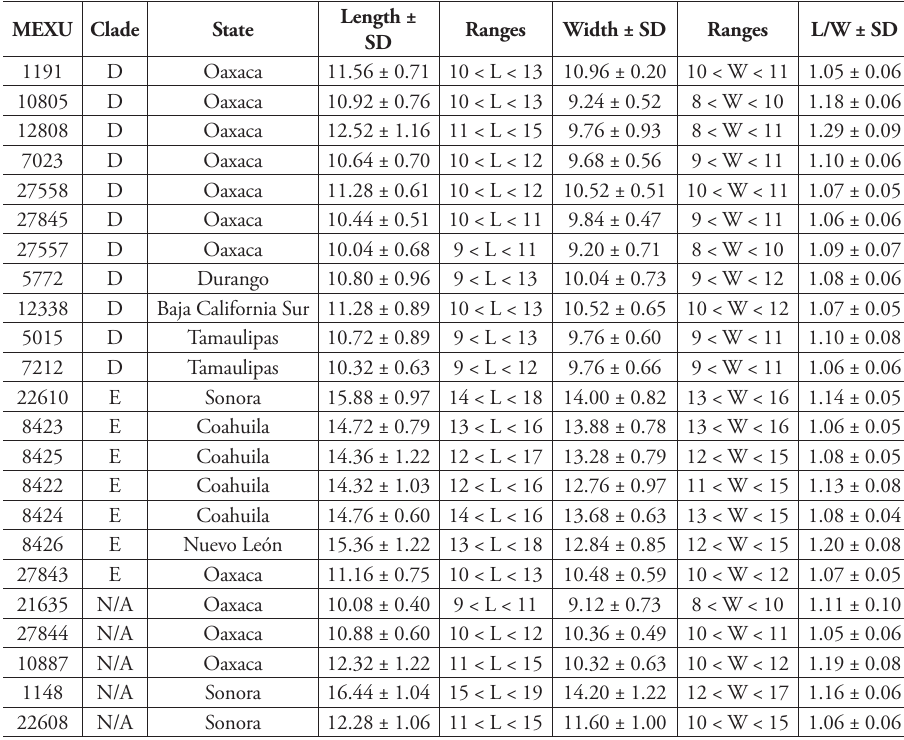
Table 2. Basidiospore